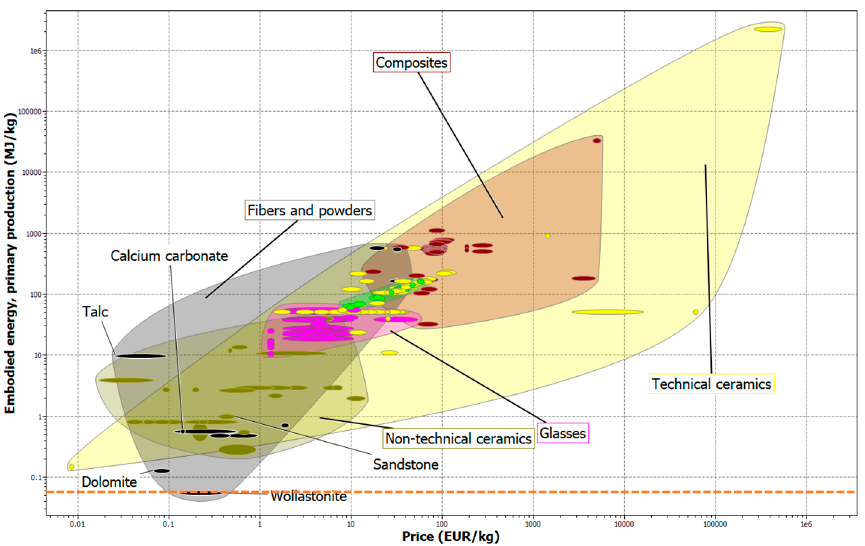
Figure 9. Embodied energy, primary productions (MJ / kg) vs. price (EUR / kg) of various materials and composites.